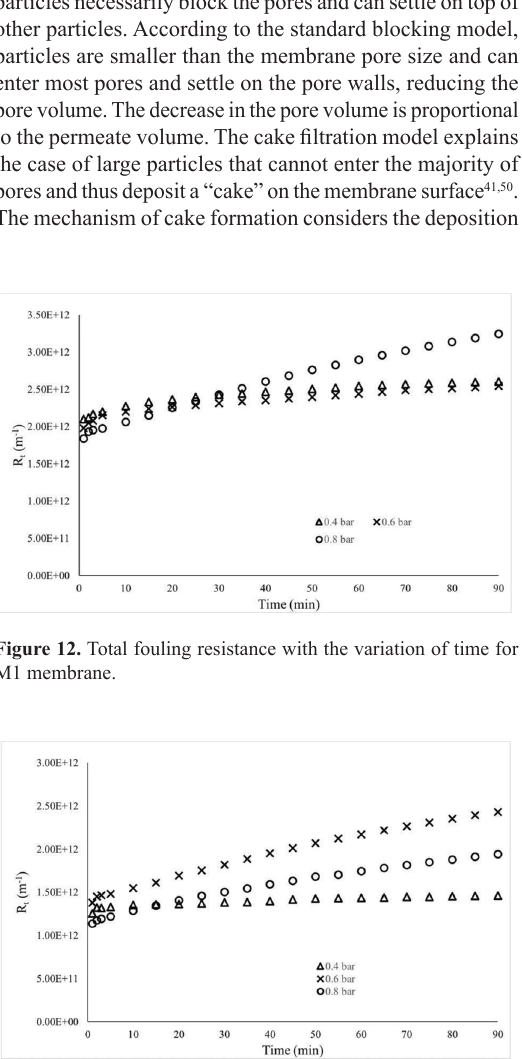
Table 2. Estimated parameters of the model.